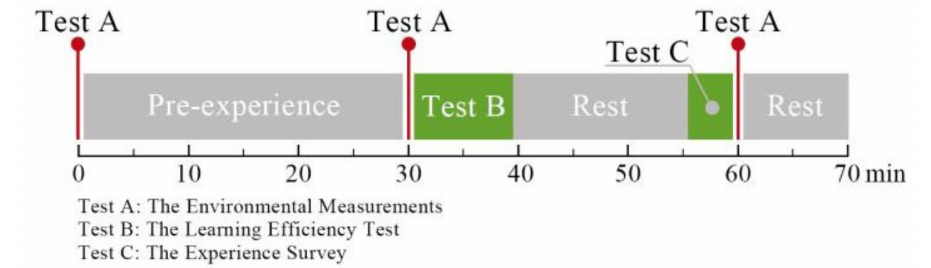
Figure 5. Schedule of the experiment process.